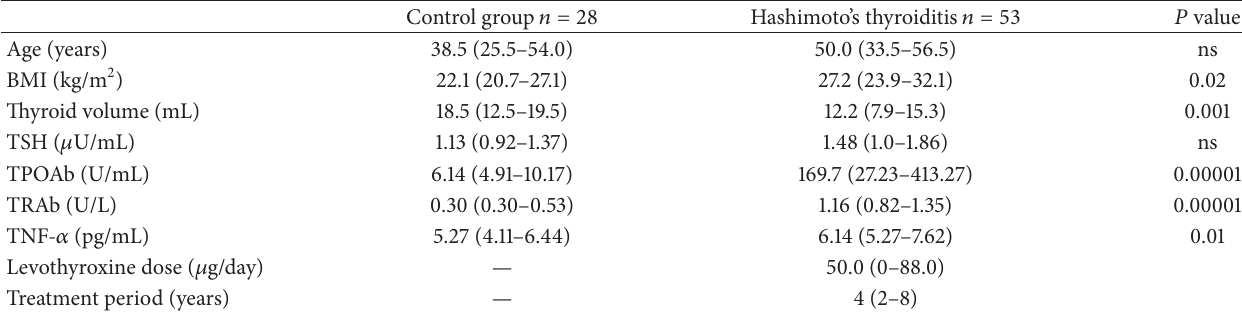
Table 1: Clinical and biochemical characteristics of the groups